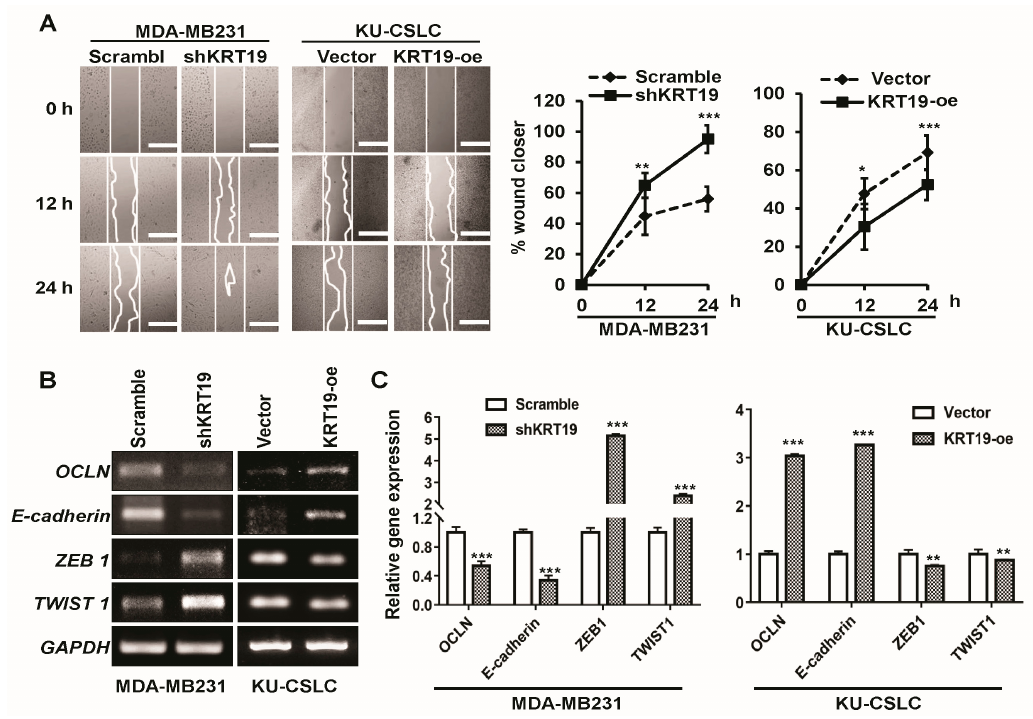
Figure 4. Knockdown or overexpression of KRT19 highly enhances or inhibits cancer wound healing migration ability in MDA-MB231 or KU-CSLC cells. ( A ) Migration ability of the indicated cells was analyzed using a wound-healing migration assay. The percentage (%) of the enclosure was captured by phase contrast microscopy (left panel) (Scale bar represents 500 μ m) and was presented as a percentage (%) of the enclosure (right panel) at the indicated time points. * p < 0.05; ** p < 0.01; *** p < 0.001; ( B , C ) mRNA expression levels of epithelial and mesenchymal transition (EMT) marker genes ( OCLN , E-cadherin , ZEB1 , and TWIST1 ) were analyzed in the indicated cells using RT-PCR analysis. The specific band intensity was measured using the scanning densitometry program in ImageJ and normalized to that of a housekeeping gene, GAPDH . ** p < 0.01; *** p < 0.001.